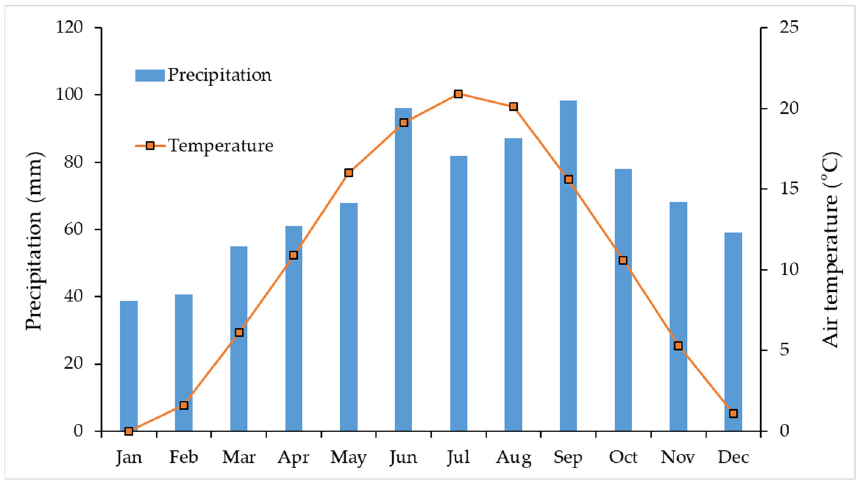
Figure 3. Mean monthly precipitation and air temperature in Varaždin area in the 1981–2010 period.